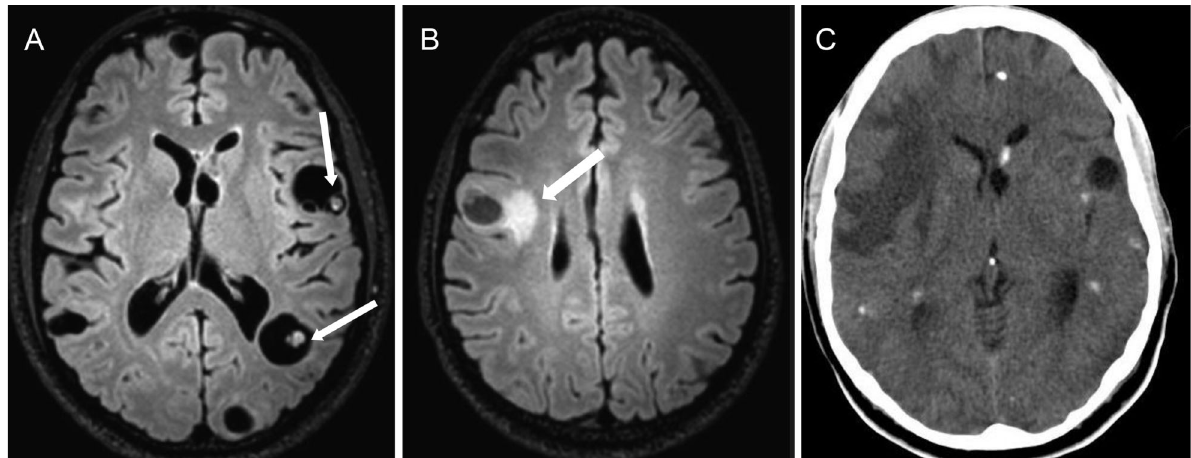
Figure 10 - Disseminated parenchymal neurocysticercosis in a 23-year-old man with intractable epilepsy and multiple epileptic foci (video-EEG). A) An axial T2 FLAIR sequence showing multiple vesicular cysts, some with scolex inside (white arrows). B) An axial T2 FLAIR image revealing perilesional edema in the right frontal lobe (white arrow). C) An axial TC shows multiple calcified lesions. These findings characterize the different phases of neurocysticercosis, which are pathognomonic of this